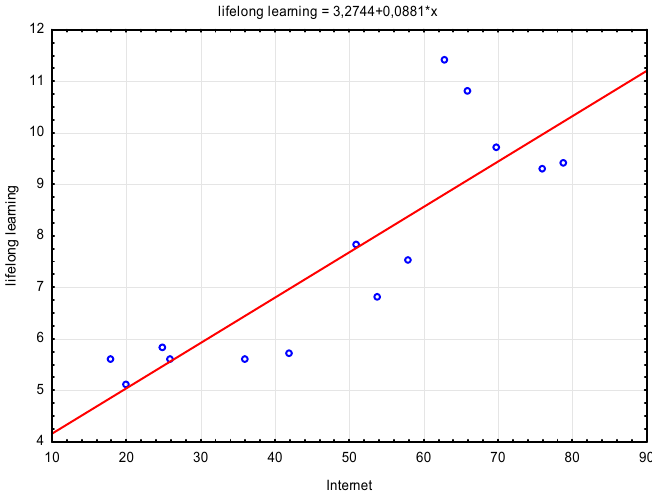
Figure 4. Scatter plot of the relation between Internet accessibility and lifelong learning.